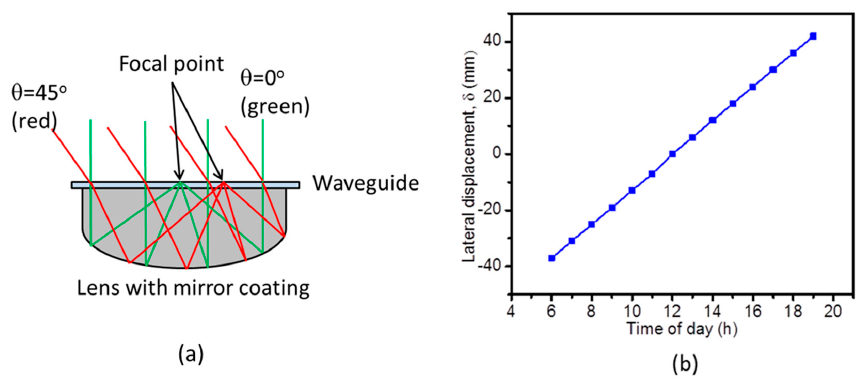
Figure 11. ( a ) Illustration of focal point displacement when sunlight incident angle changes from 0 ◦ to 45 ◦ ; ( b ) Dependence of displacement of focal point on the course of the day.